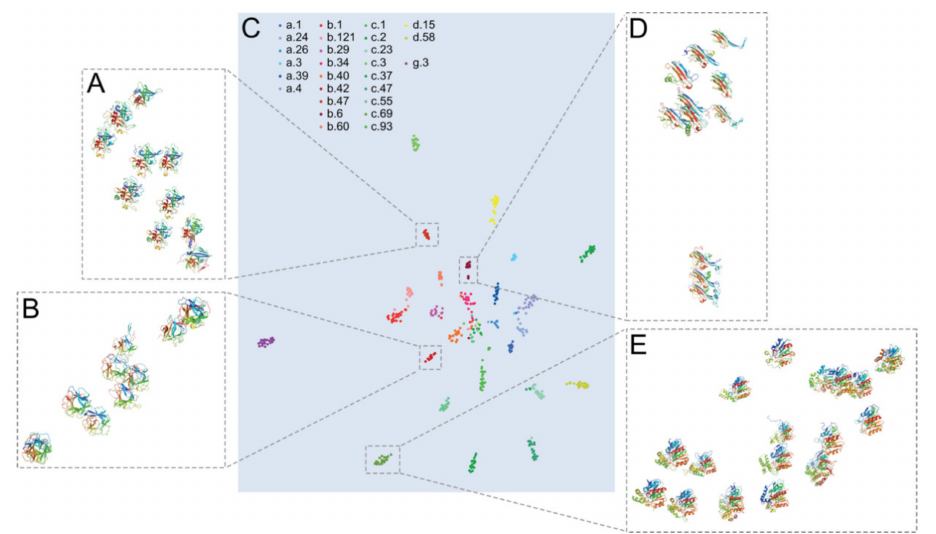
Figure 4. t-SNE embedding of global feature vectors retrieved from test proteins from the eDD dataset onto an R 2 plane. Proteins from the same structural class (such as all α proteins) are shown with similar colours (panel ( C )). Side panels ( A , B , D , E ) show zoomed proteins from b.47, b.42, b.6, and c.69 folds, respectively, which are set within dashed rectangles on panel ( C ). All proteins within each group were structurally superimposed over one central protein of that group using PyMOL software [18], which was also used for rendering protein